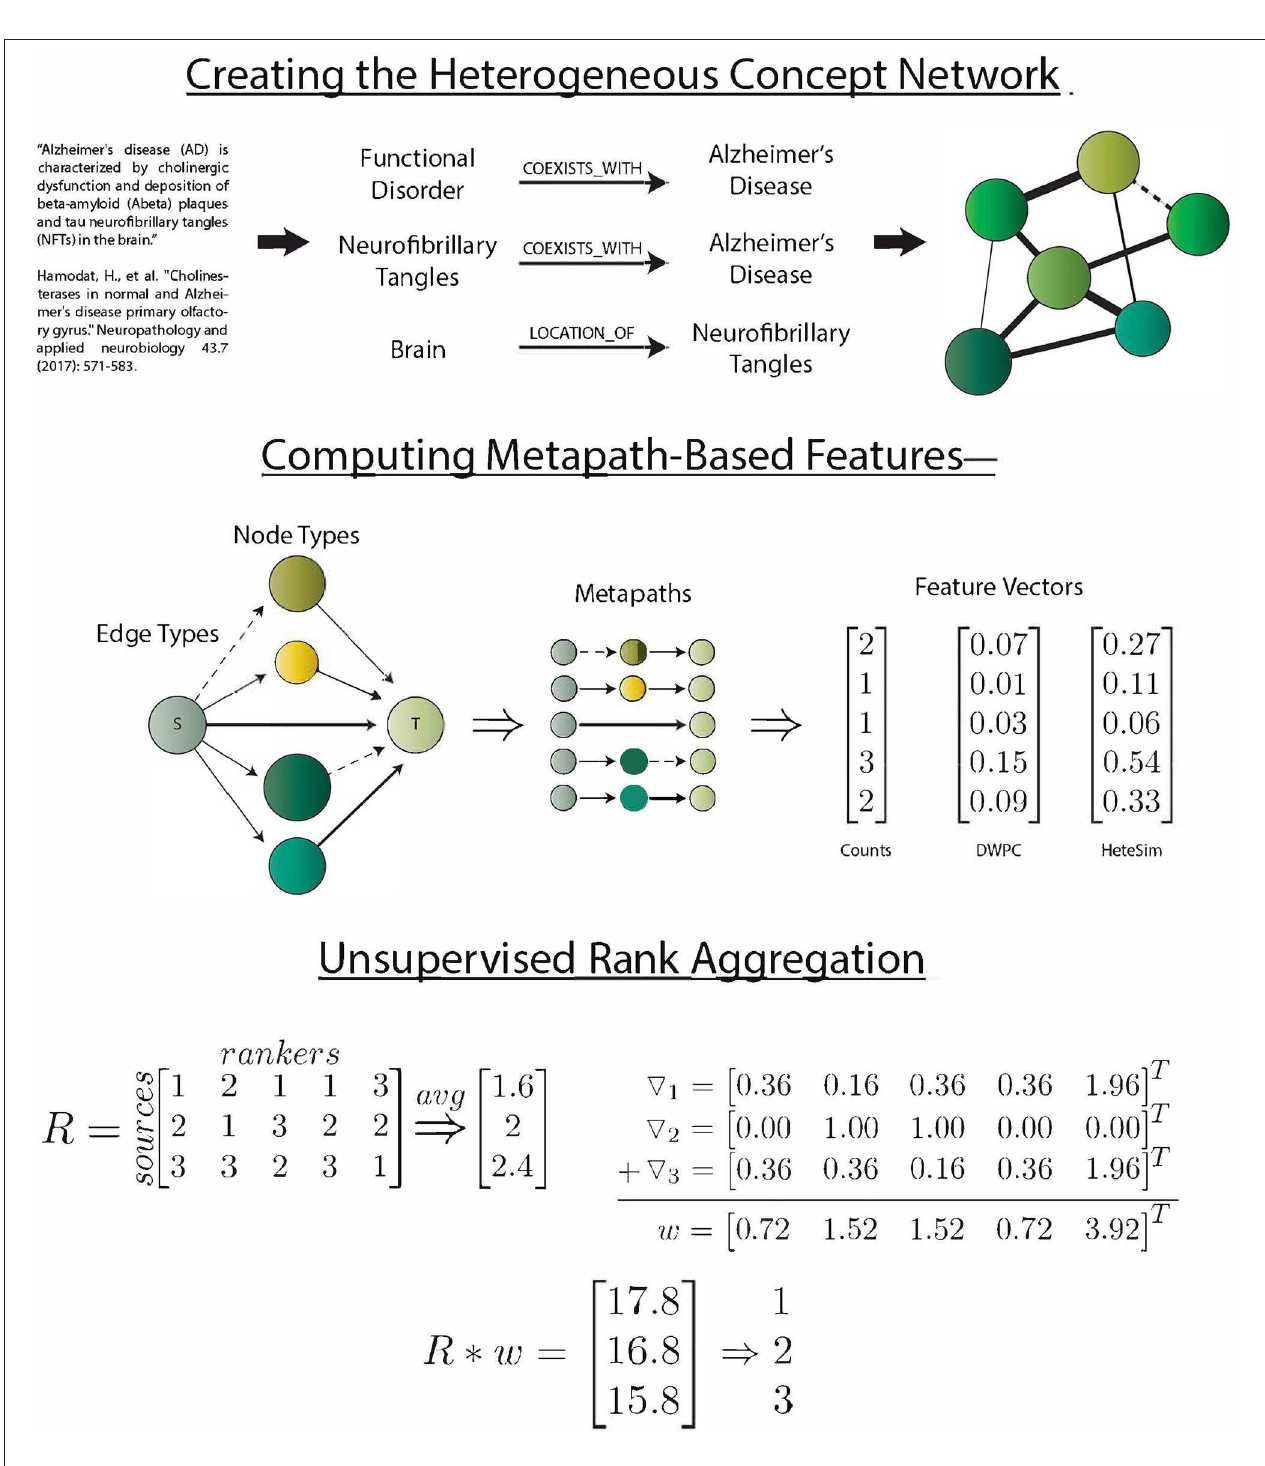
FIGURE 1 | SemNet: a visual overview of the key methods used to create the network, compute metapath-based features, and aggregate rankers. The heterogeneous information network was extracted by running the SemRep predication extraction algorithm on all abstracts in PubMed. Three different metapath-based features were calculated in order to vectorize the complex connections between source and target nodes. Finally, an aggregate ranking scheme (Klementiev et al., 2007) was used to combine feature information into a useful ranking of source nodes with respect to target nodes.